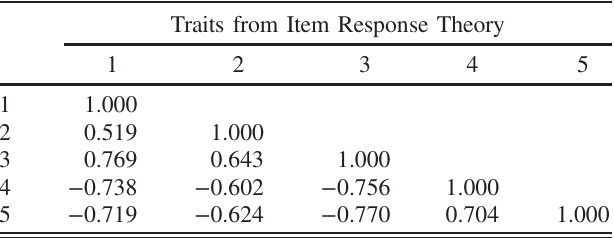
between the five traits they possess. The traits are identified by indices i and j which take values i; j ¼ 1 , 2, 3, 4, 5. As the table is symmetric with respect to its main diagonal, only the lower half is